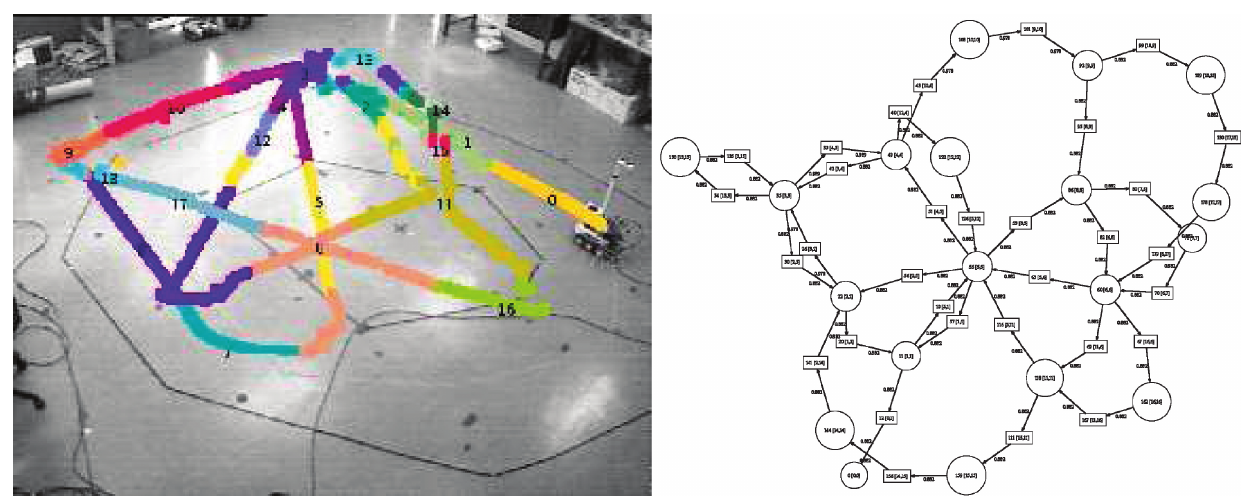
Figure 13. ( Left ) Place fields superimposed to the environment during a partial exploration. They are only recorded along the performed path. ( Right ) Cognitive map after the partial exploration of the same environment as in Figure 13 . Circles represent transitions from one place to itself. Squares represent transition cells. Edges link successive cells. Number between brackets indicate the source and the destination cell number in CA. Values on the edges are the weights of the cognitive map. PCs are automatically recruited if the maximal activity of all PCs in ECs is below 0 . 60 . The number of learned cells is higher than in the previous experiment. Some weights are different because learning has